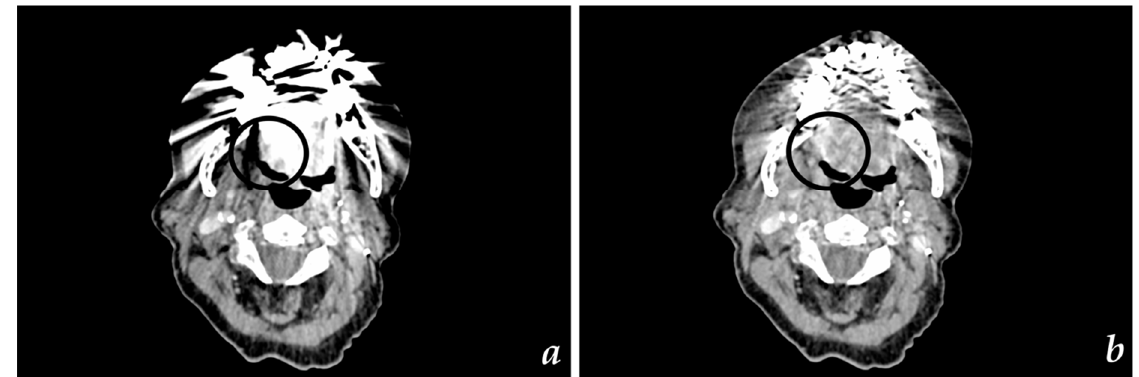
Figure 3. Axial CT images of ( a ) recurrent HNSCC of tongue edge (highlighted) without SEMAR reconstruction and ( b ) recurrent HNSCC of tongue edge (highlighted) with SEMAR reconstruction.